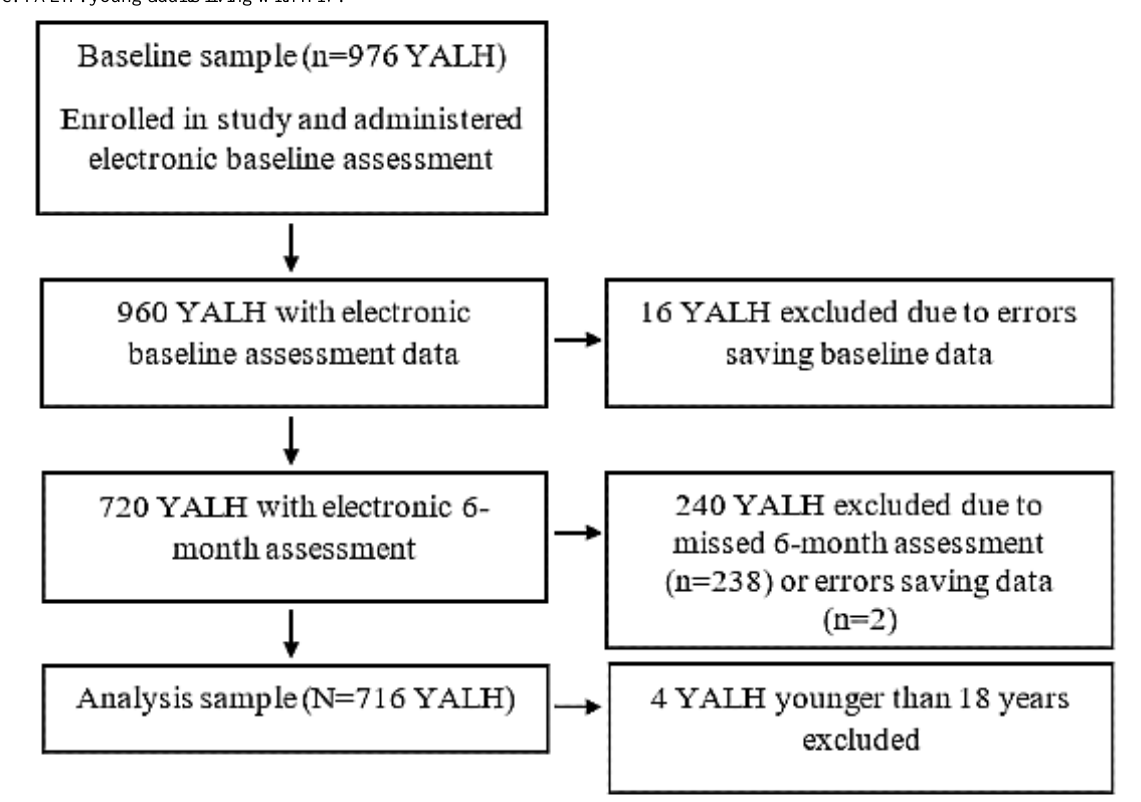
Figure 1. Sample selection process for analyses using baseline data to predict internet health information–seeking behaviors assessed 6 months after baseline. YALH: young adults living with